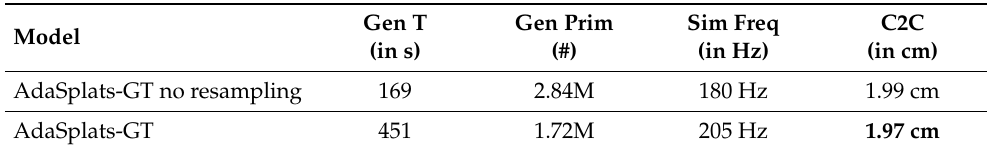
Table 2. Results of the LiDAR simulation on the PC3D-Paris using AdaSplats with ground truth semantics without resampling (top row), compared to the simulation on the resampled model (bottom row). We report the time taken (Gen T) in seconds to generate the primitives, the number of generated primitives (Gen Prim) in millions (M), simulation frequency (Sim Freq) in Hz, and the Cloud-to-Cloud Distance (C2C) in cm between simulated and original point